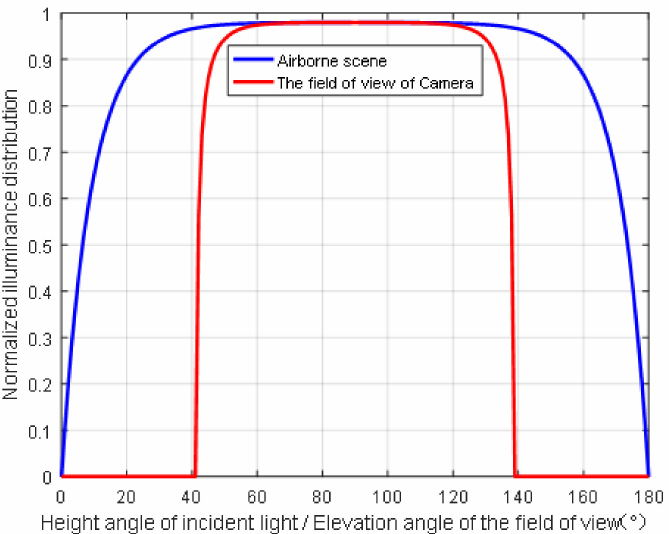
Figure 2. Normalized illuminance distribution of Snell’s window for flat